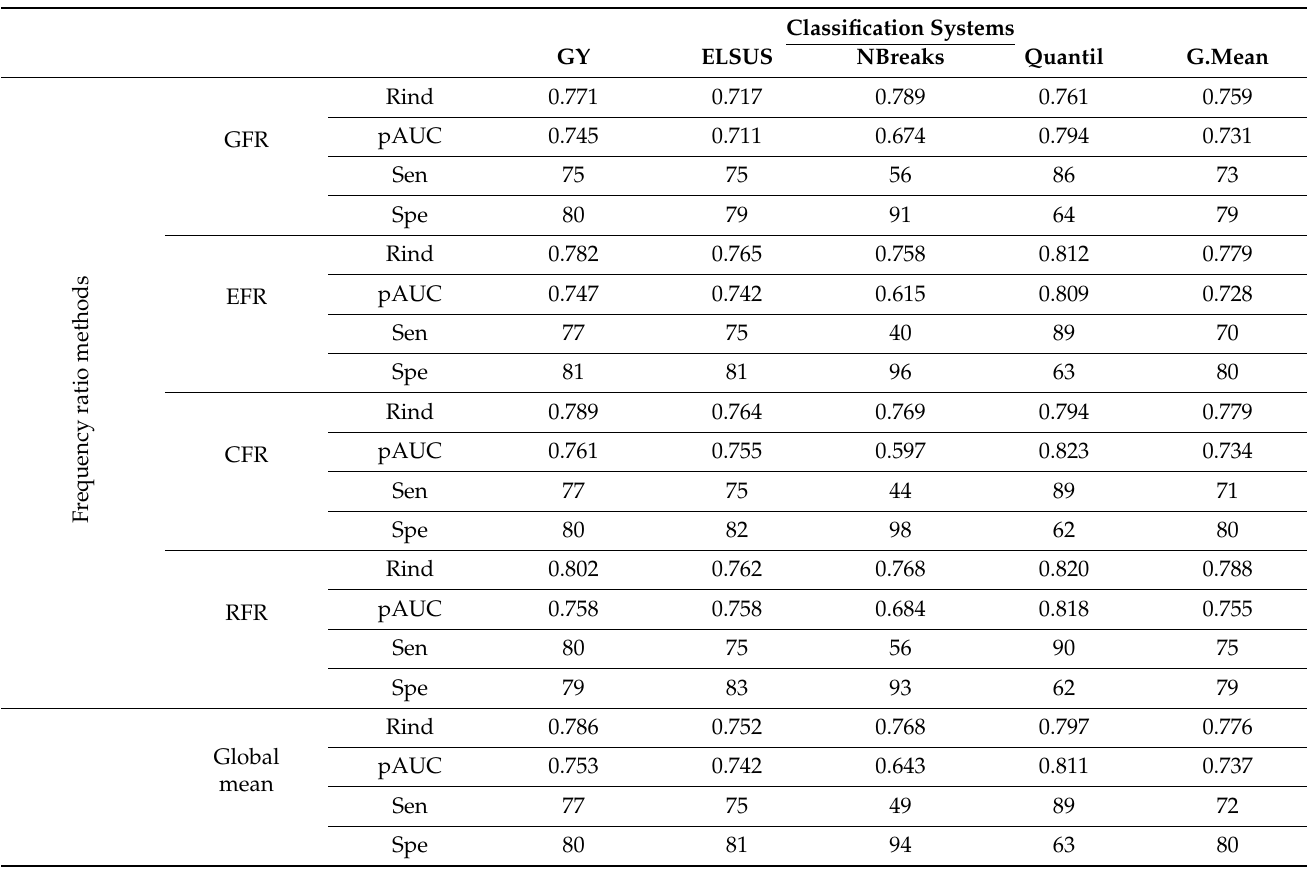
Table 10. Mean values of indicators for the three